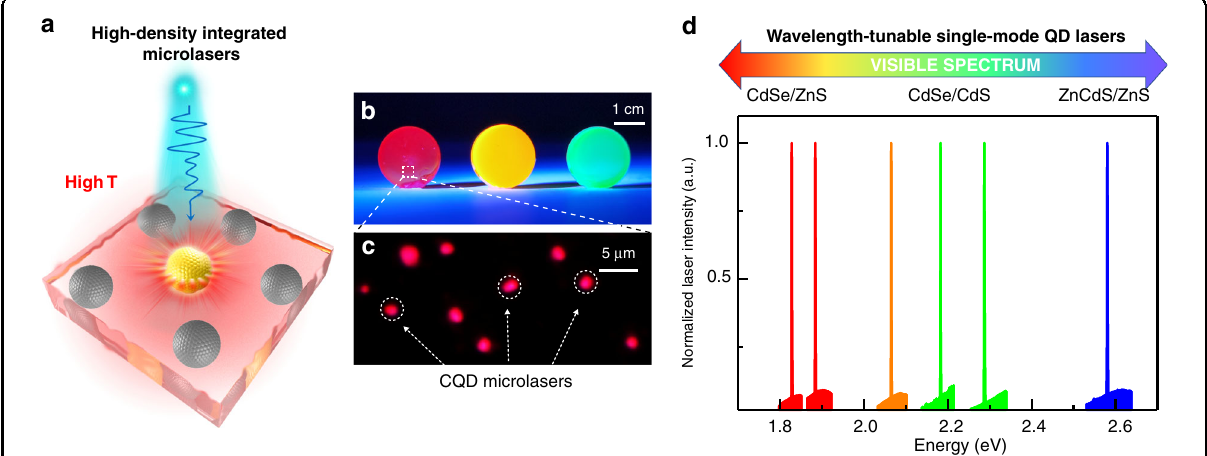
Fig. 4 High-density integrated lasers and broad wavelength-tunable single-mode lasers at high temperature based on CQDAMs. a Schematic diagram of the mass-produced integrated CQD microlasers working at high temperature. b Real-color image of the different CQD-based silica matrix samples excited by ultraviolet light. c The corresponding internal enlarged microscopic image under high-excitation condition. The red dots are the lasing CQDAMs at 400 K. d Multicolor single-mode lasers coming from CQDAMs of different compositions and/or sizes, the lasing energies of which cover the entire visible